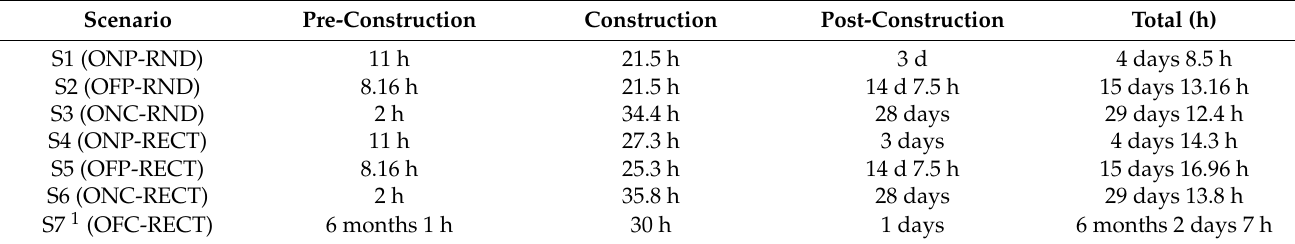
Table 3. Schedule comparison of all